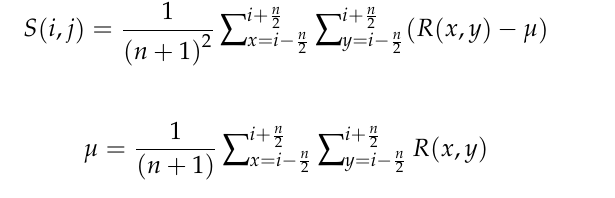
Figure 2. Visualization of the process of generating artifact probability maps. HR, SR, R, S, δ · S and M represent the outputs of the GAN model, the HR image, the residual map for the HR and SR calculations, the local variance map, the corrected local variance map, and the probability map for the artifacts, respectively.